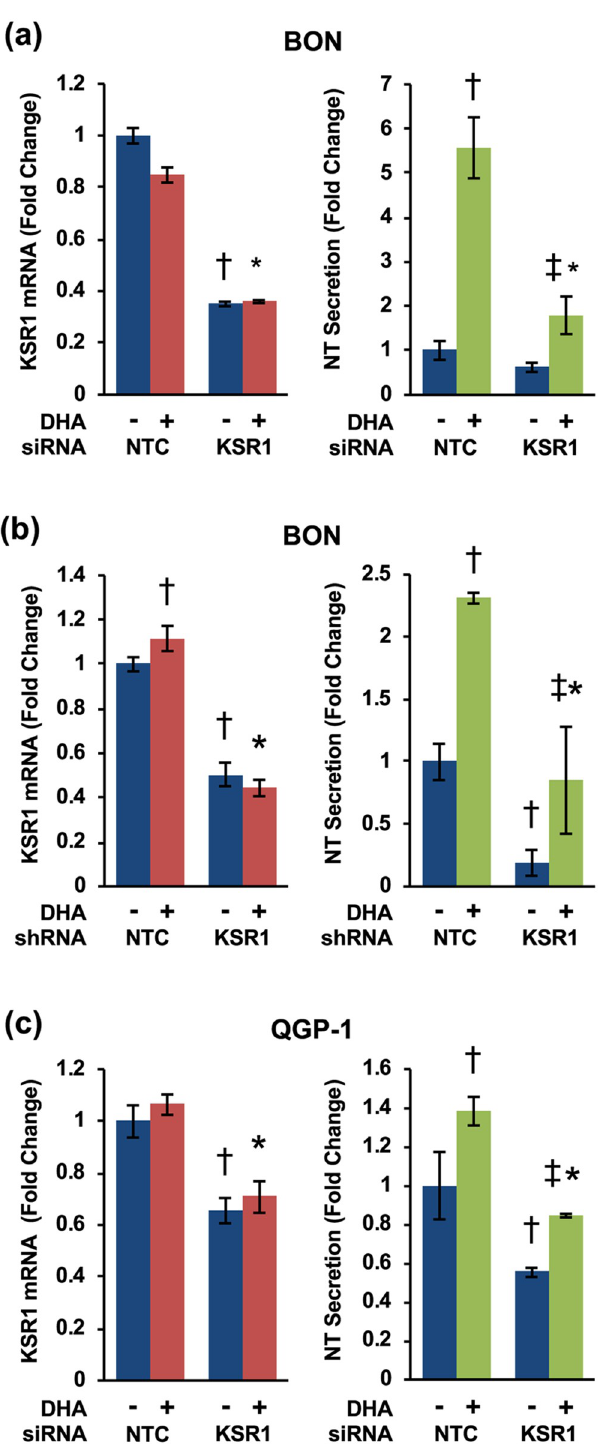
Fig 2. KSR1 inhibition attenuates FA-stimulated NT secretion. (a) BON cells were transfected with KSR1-targeting siRNA or KSR1-targeting shRNA (b) and treated with or without DHA for 90 min. Total RNA was isolated and qRT-PCR performed targeting KSR1 with GAPDH as the internal control (left) (†p < 0.05 vs. untreated NTC; � p < 0.05 vs. NTC plus DHA). Media were collected and NT-EIA performed (right) (†p < 0.05 vs. untreated NTC; � p < 0.05 vs. NTC plus DHA; ‡p < 0.05 vs. untreated KSR1-siRNA/shRNA groups.) (c) QGP-1 cells were transfected with KSR1-targeting siRNA and treated with or without DHA for 90 min. Total RNA was isolated and qRT-PCR performed